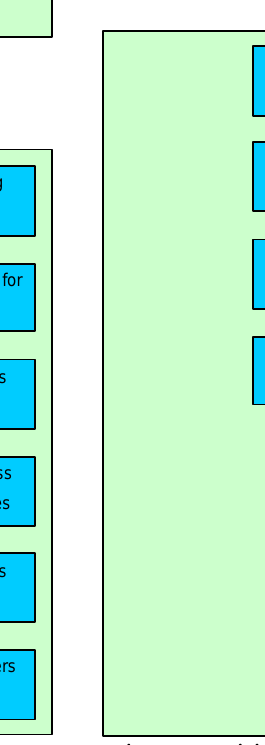
Phase 5: Reengineer the Process Activities :